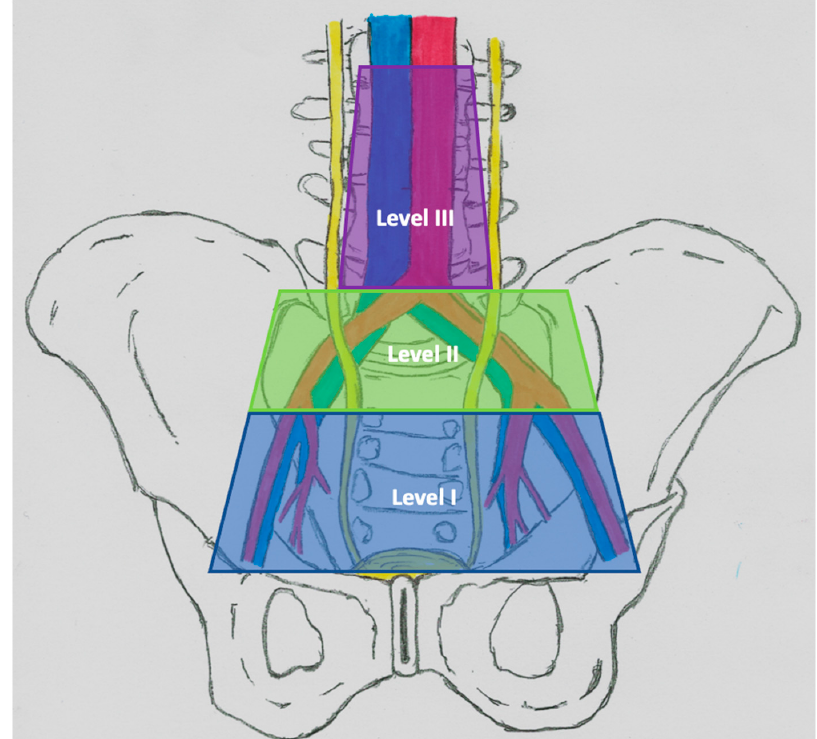
Figure 1. Anatomical range of lymphadenectomy corresponding to the resection level proposed by Leissner et al. (explanatory notes) [42].